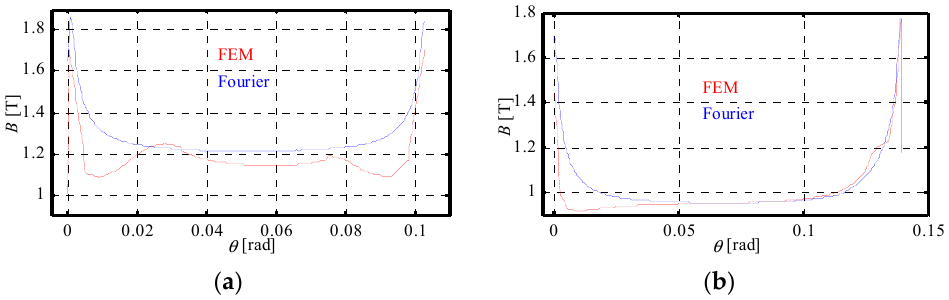
Figure 18. Flux density on the tooth base in open-circuit operation: ( a ) Qs48p8, ( b ) Qs36p15.